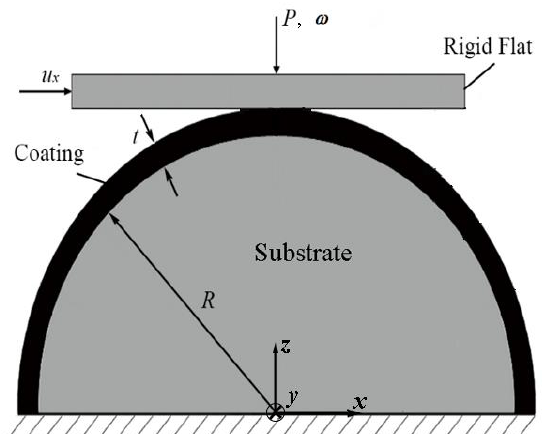
Figure 1. A model for the flattening of a coated spherical asperity, where a deformable coated sphere is in contact with a rigid flat.